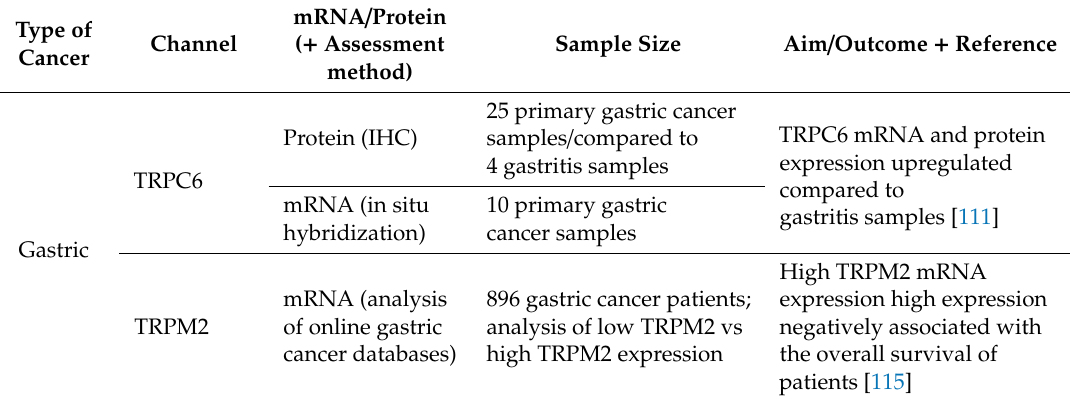
Table 5. Expression of TRP channels in human gastric cancer